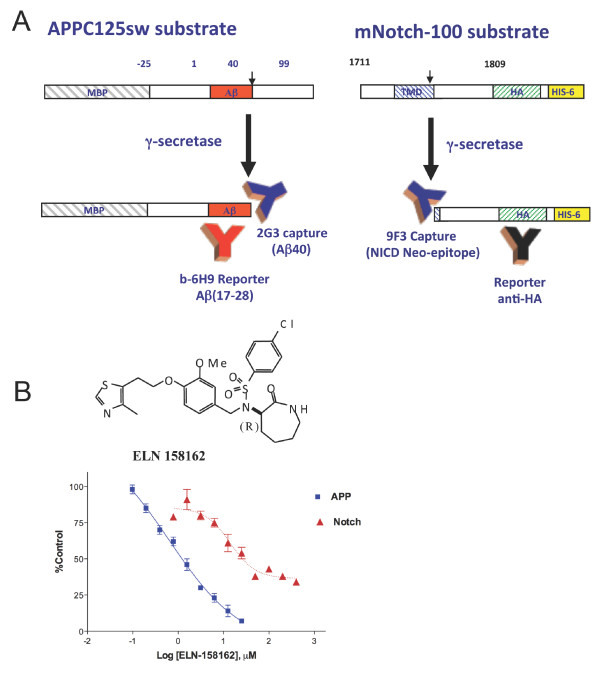
Schematic illustration of in-vitro assays, and dose response curves of an APP selective gamma-secretase inhibitor. (a) Recombinant E.coli expressed fusion protein substrates APP MBP-C125Sw (left side, numbering relative to Aβ peptide residues, red box) or mNotch100 substrate (right hand side, numbering relative to initiator methionine residue) were incubated in separate reactions with partially purified solubilized gamma-secretase enzyme from IMR-32 cells as detailed in methods. The reactions products were analyzed by ELISA using 2G3/6H9 ELISA for AβX-40 for GammaAPP assay product, or the 9F3/anti-HA ELISA for NICD, the GammaNotch assay product. MBP, N-terminal fusion with maltose binding protein (grey hatched box); TMD, transmembrane domain (blue hatched box); HA, hemagglutnin antigen epitope tag (green hatched box); HIS-6, hexahistidine residue epitope tag (yellow box). (b) Dose response curve demonstrating APP-selective inhibition from a representative screening hit ELN158762. The IC50 values for inhibition of APP and Notch substrate cleavage, and selectivity ratio in the biochemical assays with this compound are reported in Table 1.